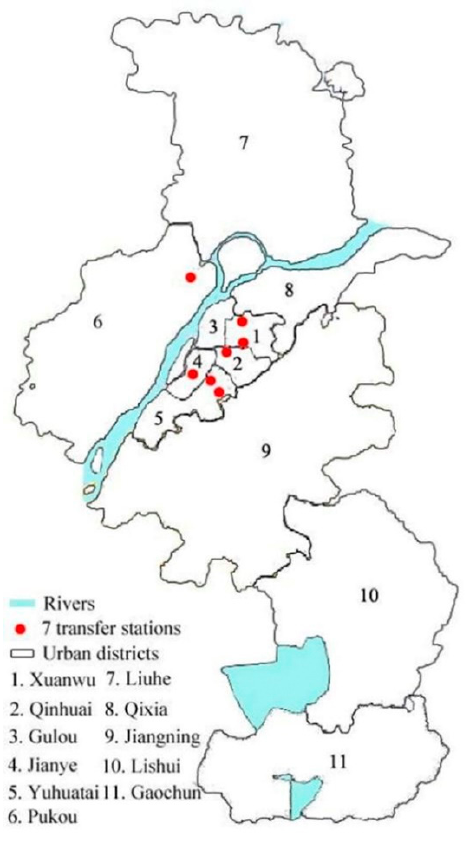
Figure 5. Location of rail transit transfer stations in Nanjing.